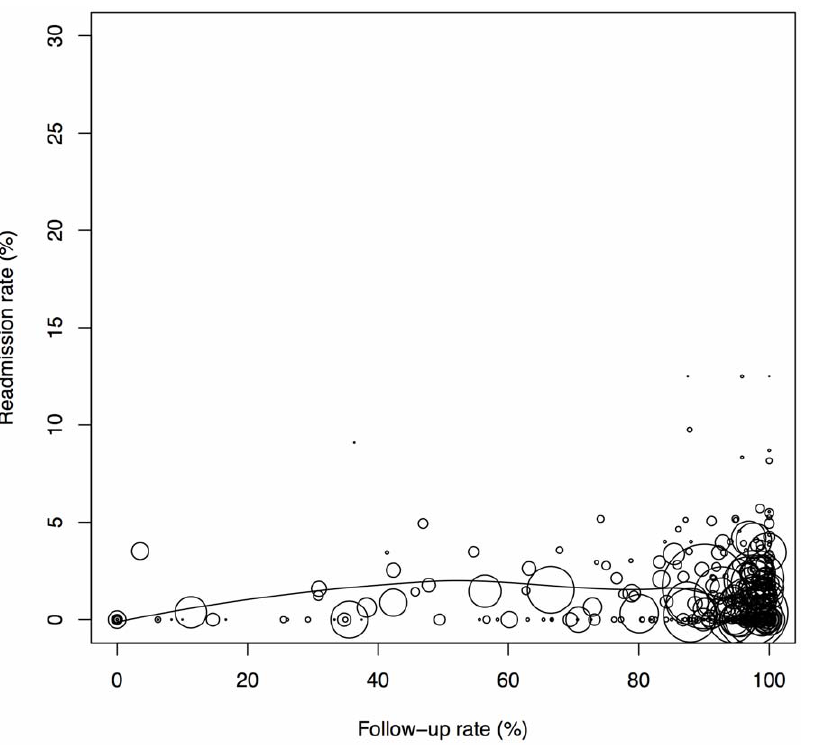
Figure 4. Loess plot of AGB readmission rates on follow-up rates. Circles represent BSCOE hospitals with the size weighted by the number of patients who underwent the procedure in the hospital during the study period.